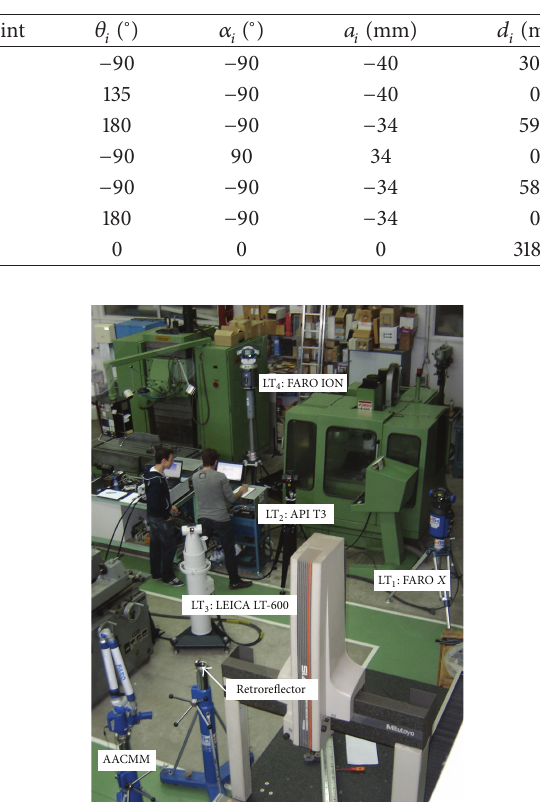
Table 1: Initial values for the AACMM D-H parameters.